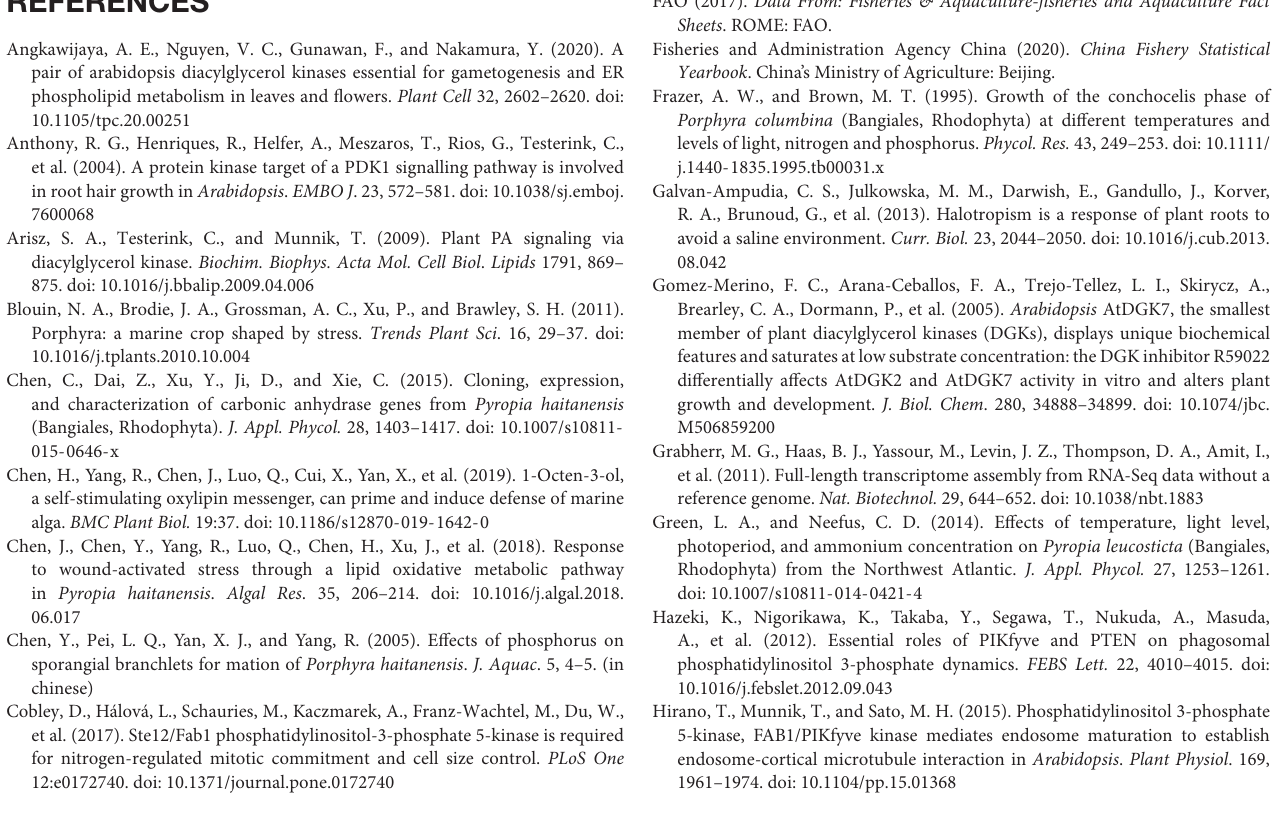
Supplementary Figure 4 | Hierarchical clustering of genes related to microtubules (A) and PLC (B) . Red: up-regulation; Blue: down-regulation. Transcript levels of genes are shown as -fold changes of RPKM compared with that at S-1-0 or S-2-0. Supplementary Table 1 | Gene-specific primers for cloning PhDGK1 and quantifying its expression. Supplementary Table 2 | Gene-specific qRT-PCR primers for verifying differentially expressed genes in Pyropia haitanensis . Supplementary Table 3 | Overview of Pyropia haitanensis transcriptome information. Supplementary Table 4 | Overview of Pyropia haitanensis annotation information. Supplementary Table 5 | All list and information of WGCNA. All.kTotal: Connectivity of all edges of the gene. All.kWithin: The degree of connectivity under this module, the sum of correlation coefficients between a gene and other genes. MM.XXX: The correlation coefficient between the gene and the eigenvalues of XXX module. MM.XXX.pvalue: The P value of the MM value of the gene and the characteristic value of XXX module. XXX meaning of the different colors of Modules. Supplementary Table 6 | The annotation of gene in different Module. Symbol: The symbol number of gene. Description: annotation of Nr database.